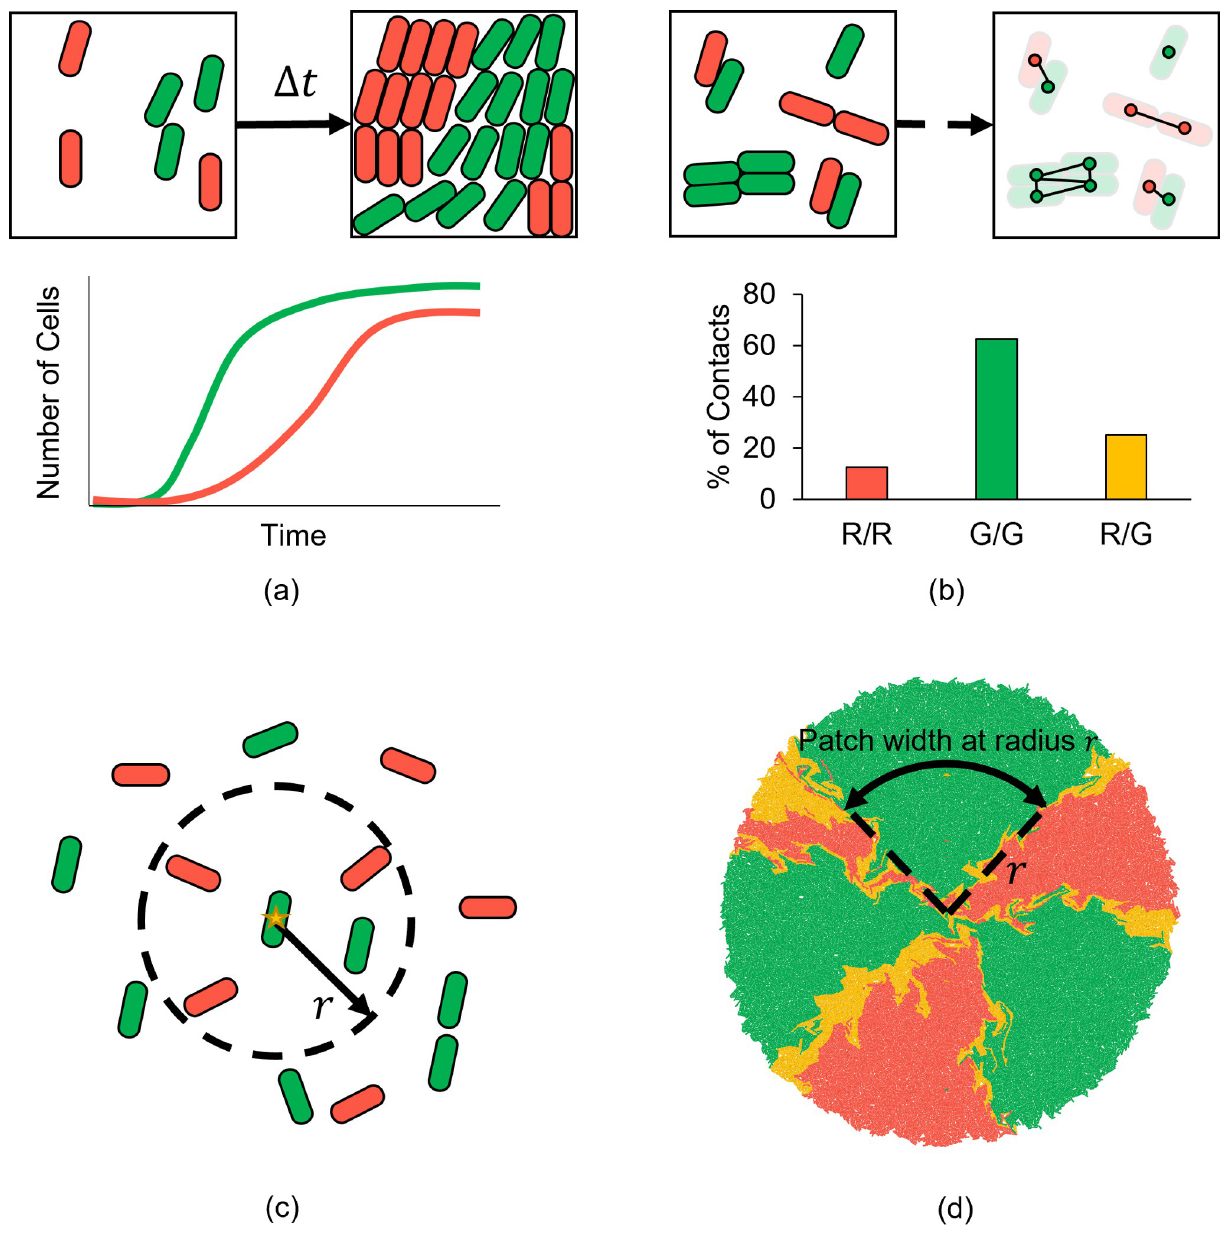
Fig 4. Calculating spatiotemporal summary statistics for microbial communities. (a) Population counts over time capture the overall dynamics in a multispecies community. (b) The frequency of adjacent species in physical contact, determined by a contact network, provides a measure of intermixing between different species. (c) Summary statistics can be calculated from data averaged within a particular cell’s neighbourhood. (d) Single-species patch metrics, such as patch width and number of sectors, are useful for quantifying spatial patterns on a larger colony scale.